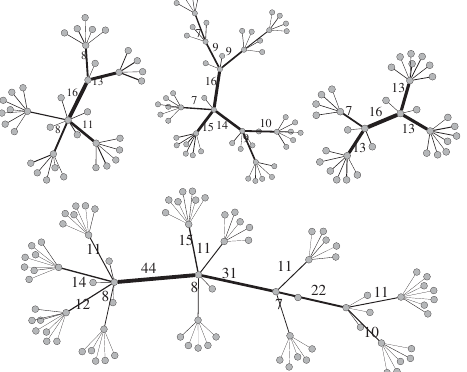
Figure 4: Four randomly generated topologies. The width and the label of the edges represent the num- ber of TCP flows (for edges with more than 5 flows).